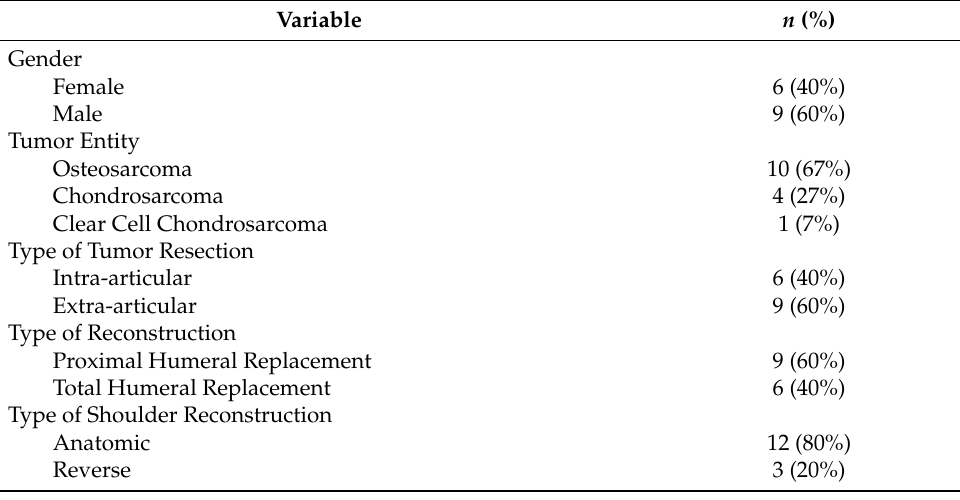
Figure 1. Study flow diagram. Table 2. Demographics, oncological and surgical